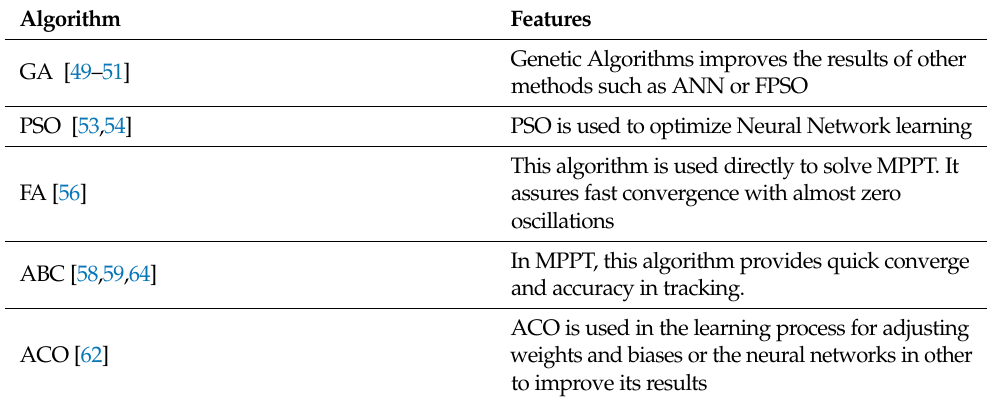
Table 3. Metaheuristic Algorithms for